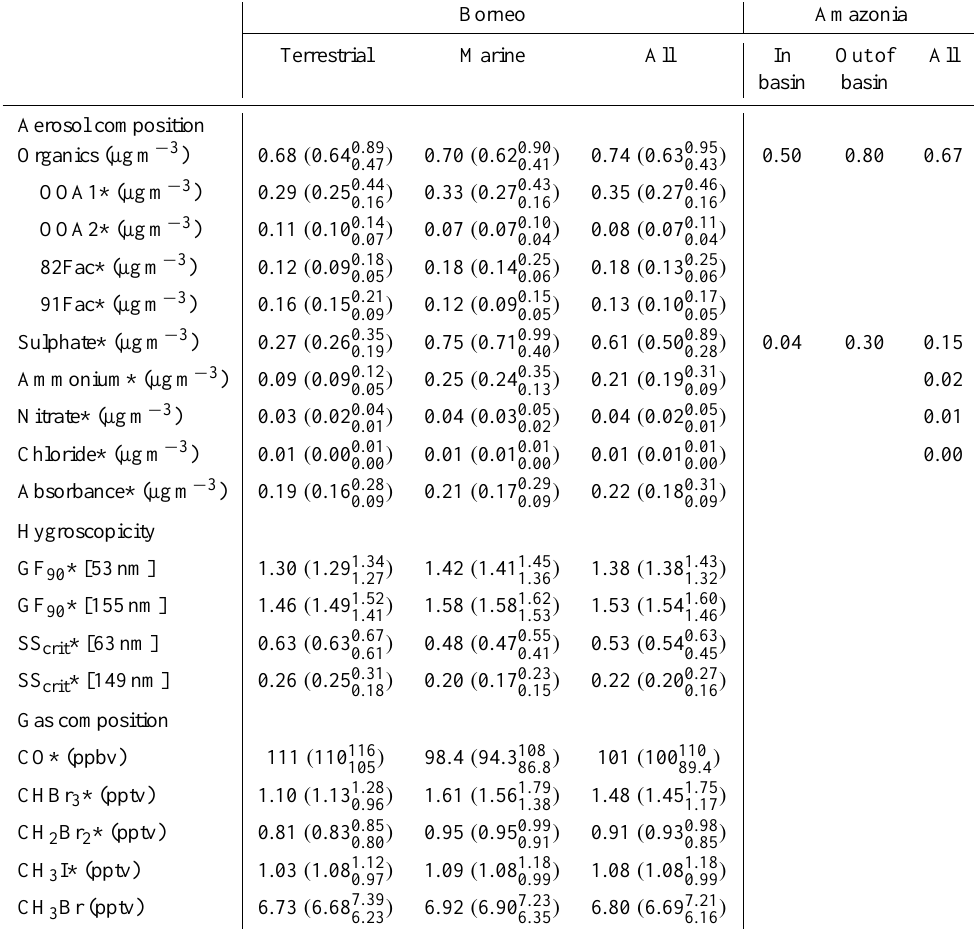
Table 4. Averages of data during 12h periods classified as belonging to the Marine and Terrestrial clusters. Values quoted in the form mean (median 75th %ile ). Marine and Terrestrial data sets that are significantly different with a 95% confidencelevel (using the two tailed 25th %ile Mann-Whitney U test (Cheung et al., 1997), which is nonparametric) are marked with an asterisk. Borneo Amazonia Terrestrial Marine All In Out of All basin